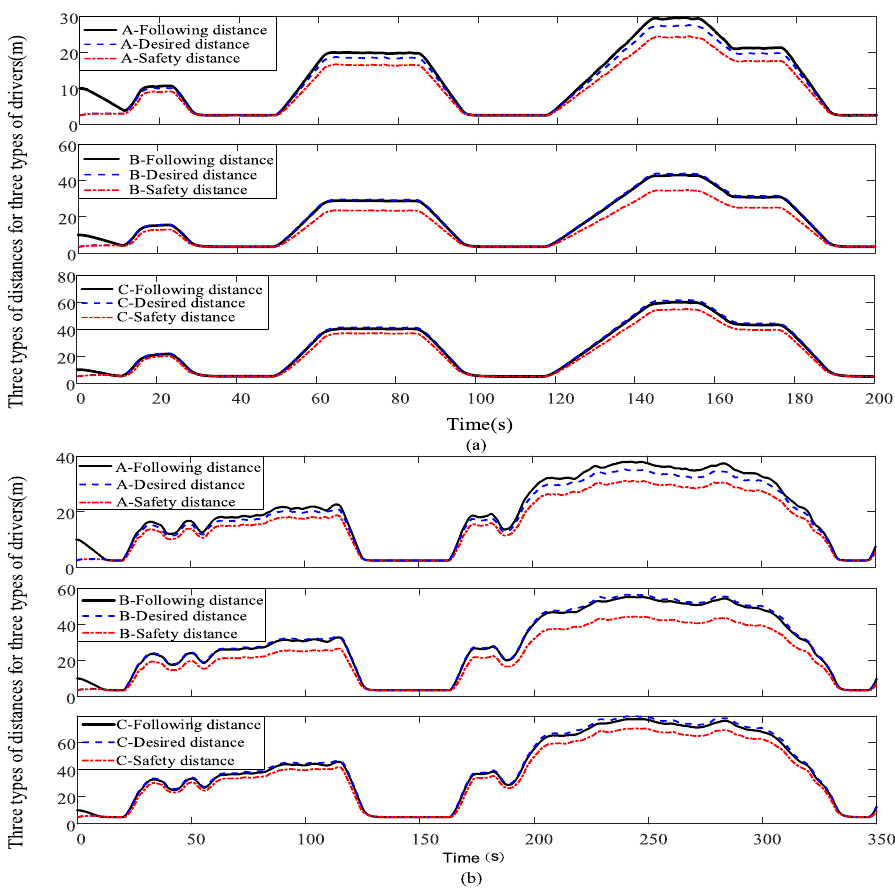
Figure 11. ( a ) Three types of driver following, ideal, and safety distances for standard operating conditions ECE. ( b ) Three types of driver following, ideal, and safety distances for the standard operating condition FTP75.